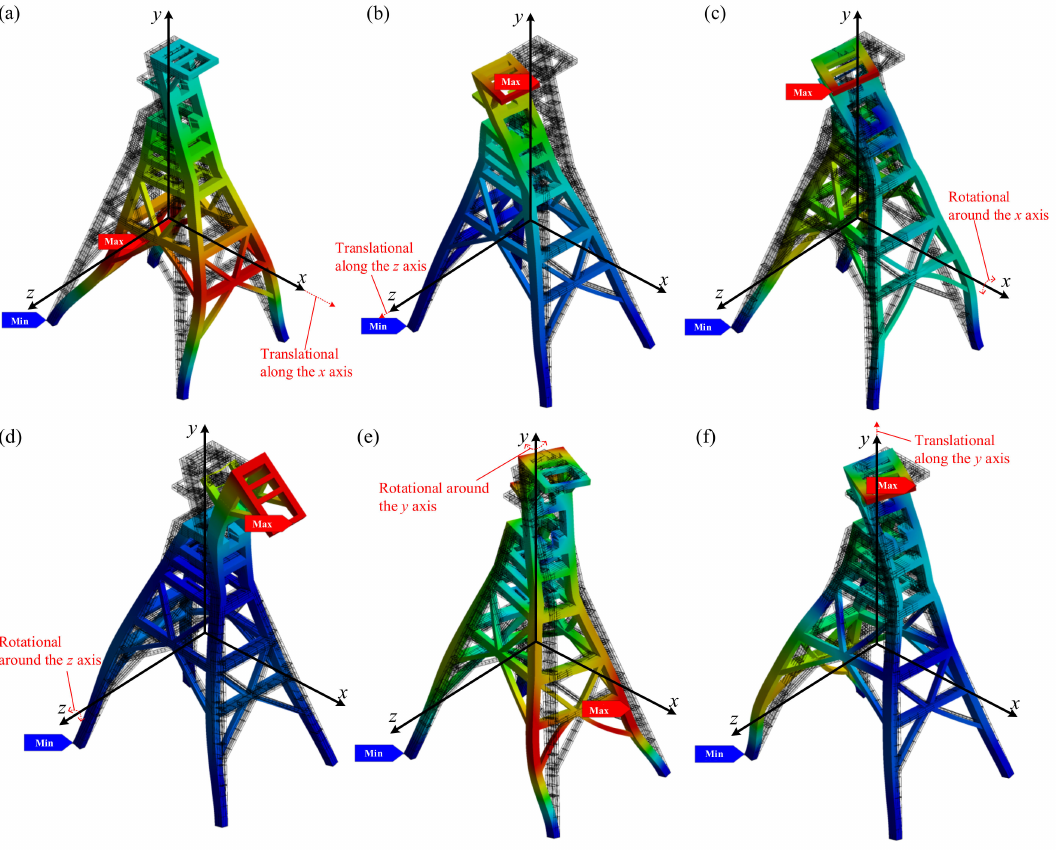
Figure 3. The first six-order vibration modes. ( a ) The first-order vibration mode. ( b ) The second-order vibration mode. ( c ) The third-order vibration mode. ( d ) The fourth-order vibration mode. ( e ) The fifth-order vibration mode. ( f ) The sixth-order vibration